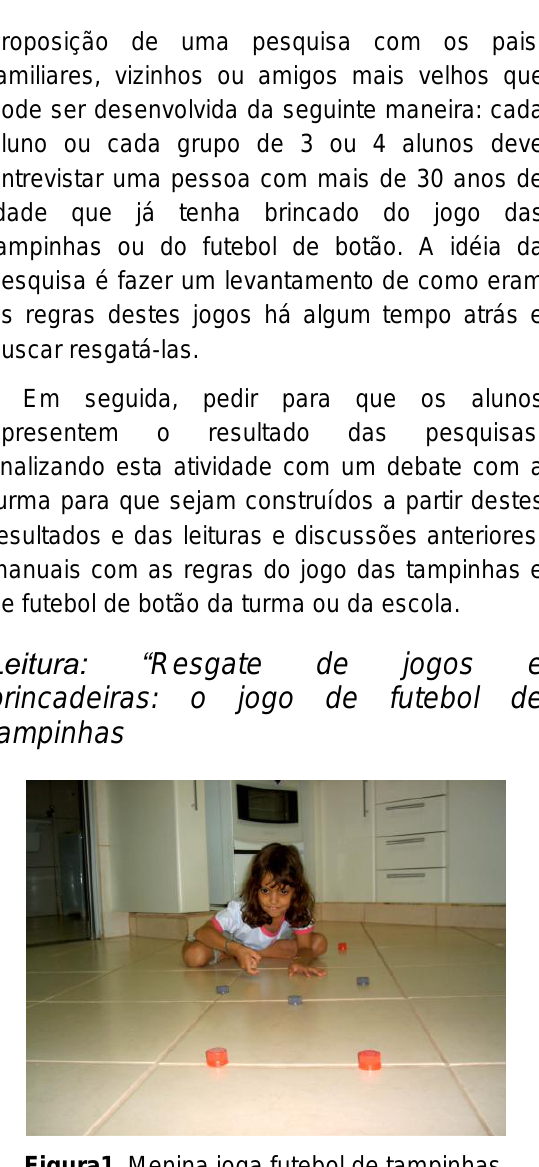
Figura1. Menina joga futebol de